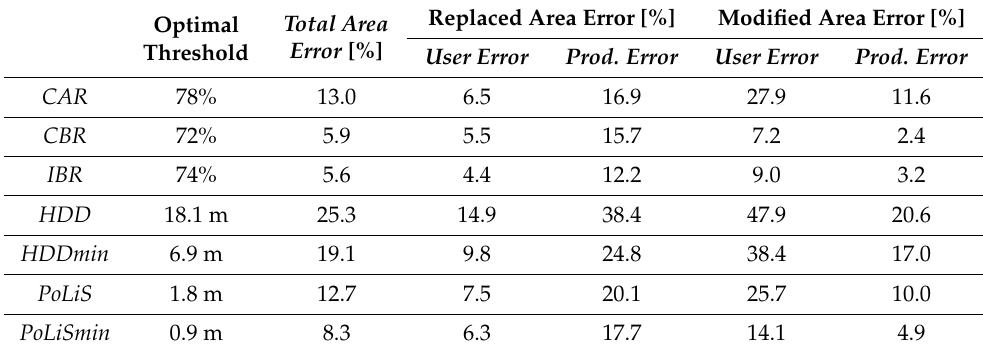
Table 2. Thresholds and accuracies of investigated matching methods for distinguishing modified from replaced buildings based on 2285 reference areas.